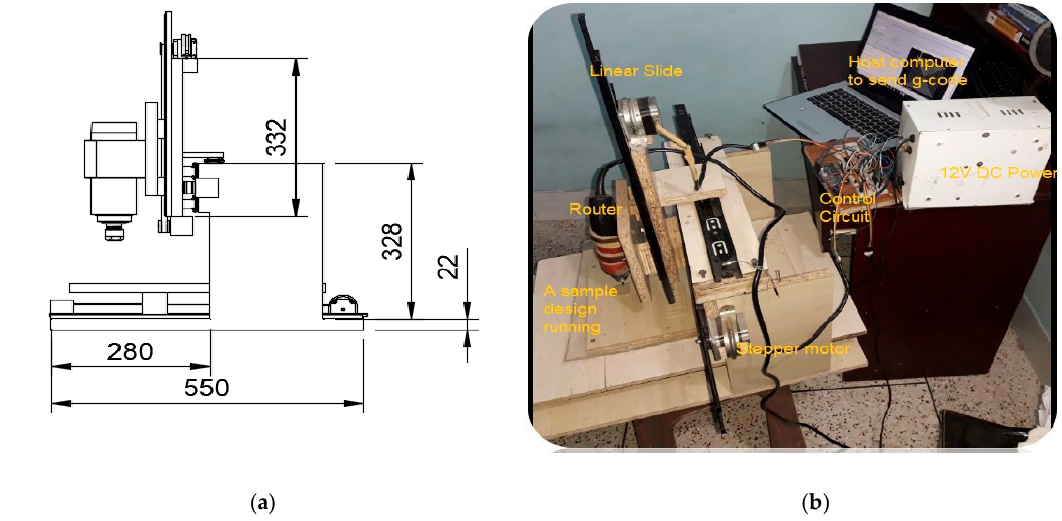
Figure 2. ( a ) Schematic of the CNC Milling Machine designed using AutoCAD 360; ( b ) Picture of the CNC Milling Machine with complete setup.